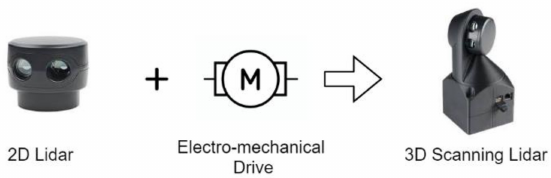
Figure 18. Conceptual design of 3D LiDAR based on 2D LiDAR module and electromechanical scanning